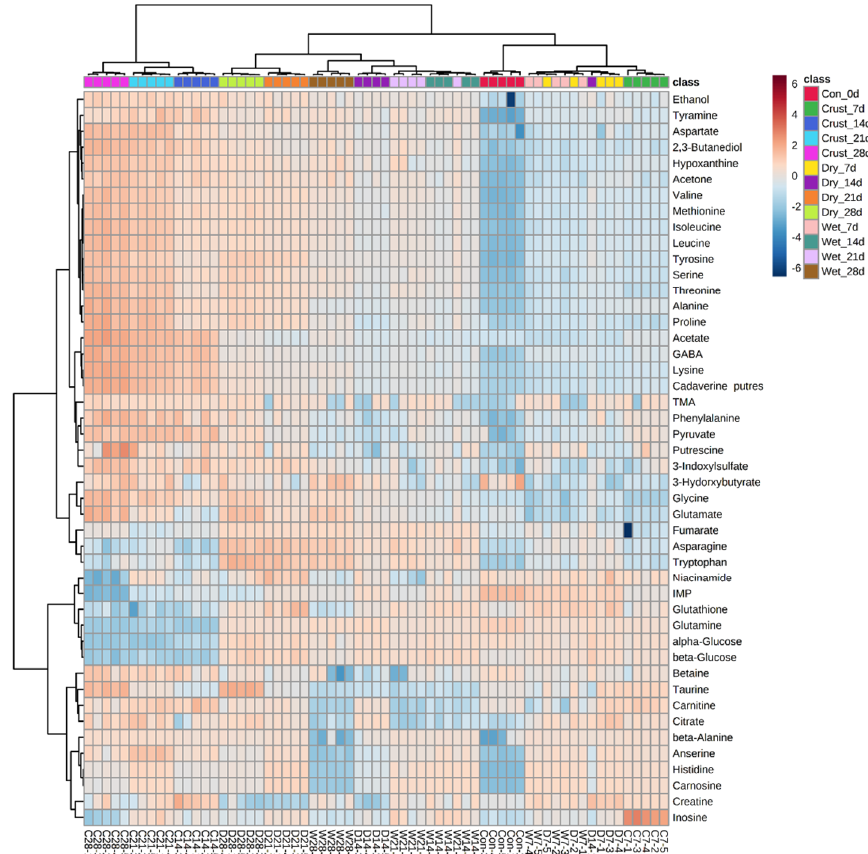
Figure 3. Heatmap analysis based on the quantified metabolites from crust, dry-aged, and wet-aged beef using 2D NMR (heteronuclear single quantum coherence, HSQC) on 850 MHz cryo-NMR spectrometer. GABA, γ-aminobutyric acid; TMA, trimethylamine; IMP, inosine 5′-monophosphate.